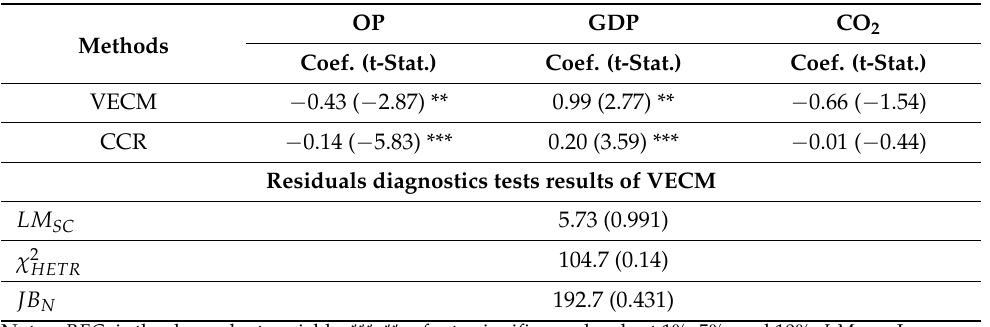
Table 5. Long-run coefficients from the VECM